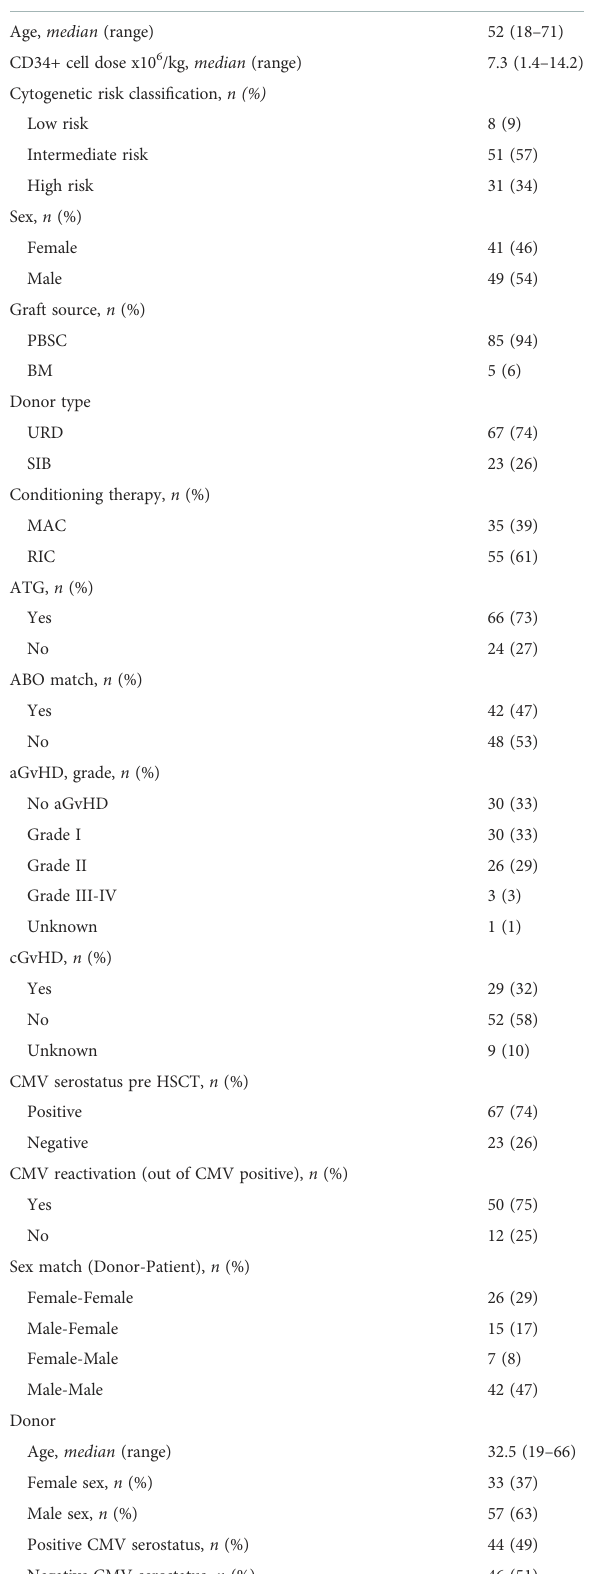
TABLE 1 Patient